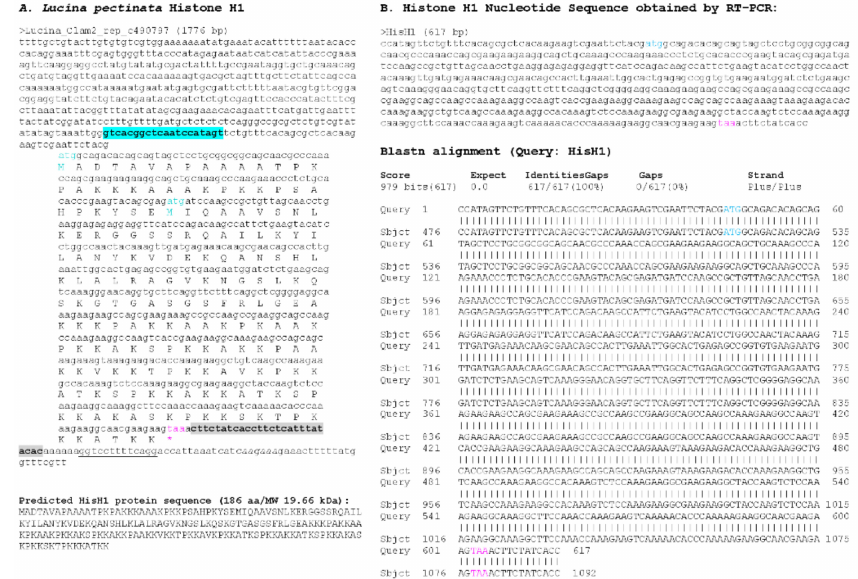
Figure 4. Histone H1_A sequence found in Lucina pectinata genome assembly. ( A ) One of the two H1-like nucleotide sequences obtained from the BLASTN searches against the L. pectinata genome assembly using the H1 nucleotide sequence from S. marginatus is shown, including the coding region, the predicted protein sequence and its molecular weight (MW). ( B ) The nucleotide sequence obtained by Sanger sequencing of RT-PCR products followed by the BLASTN alignment of the cDNA to the genomic sequence, showing a perfect match between the two sequences. Primers used in RT-PCR are highlighted in cyan and grey. Start (cyan) and stop (pink) codons are